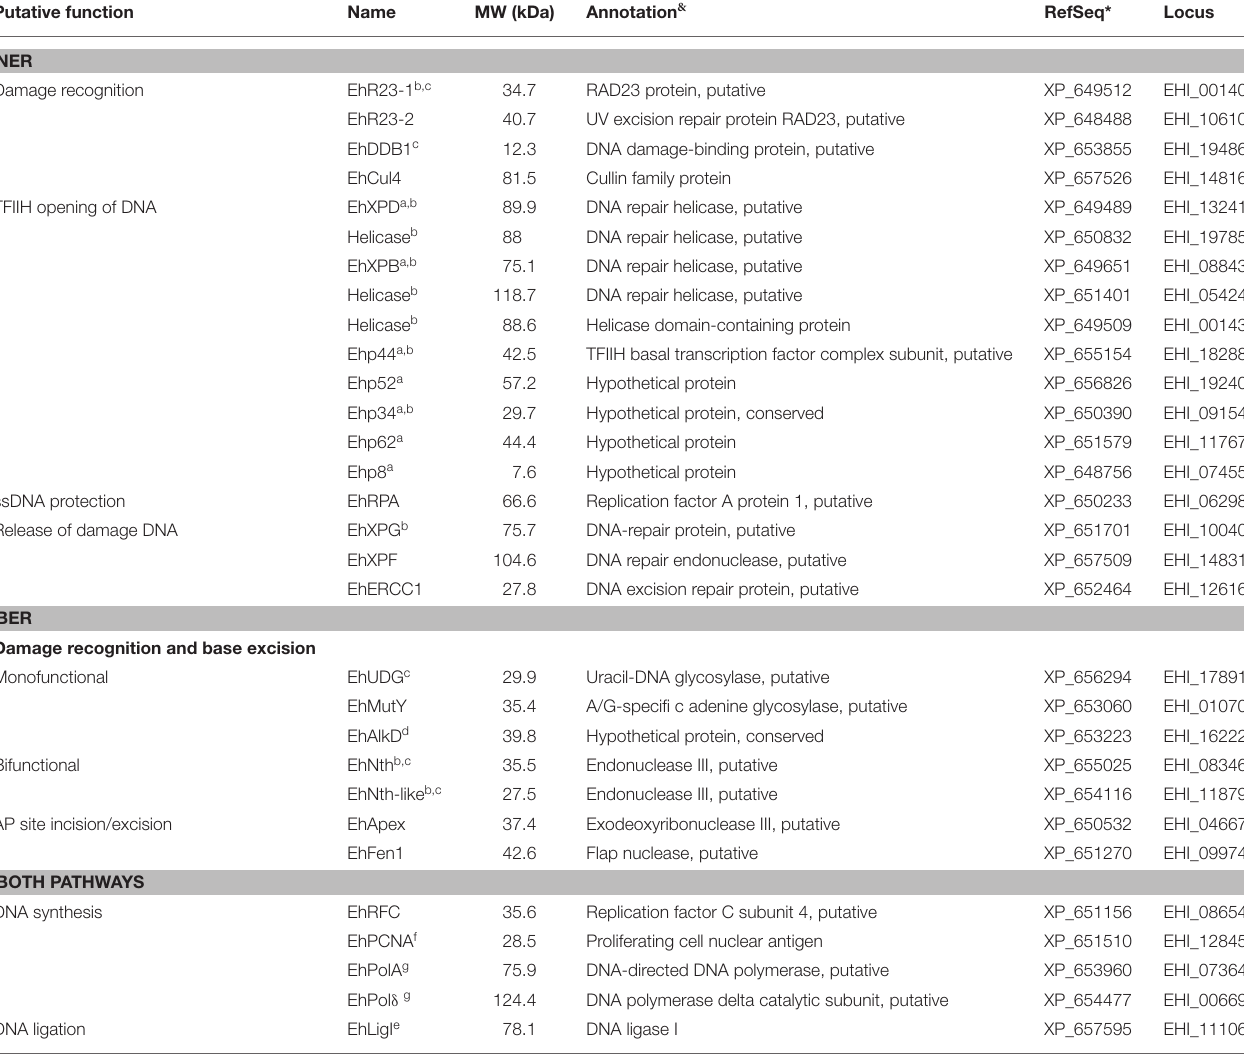
TABLE 2 | Proteins from the NER and BER pathways in Entamoeba histolytica . Putative